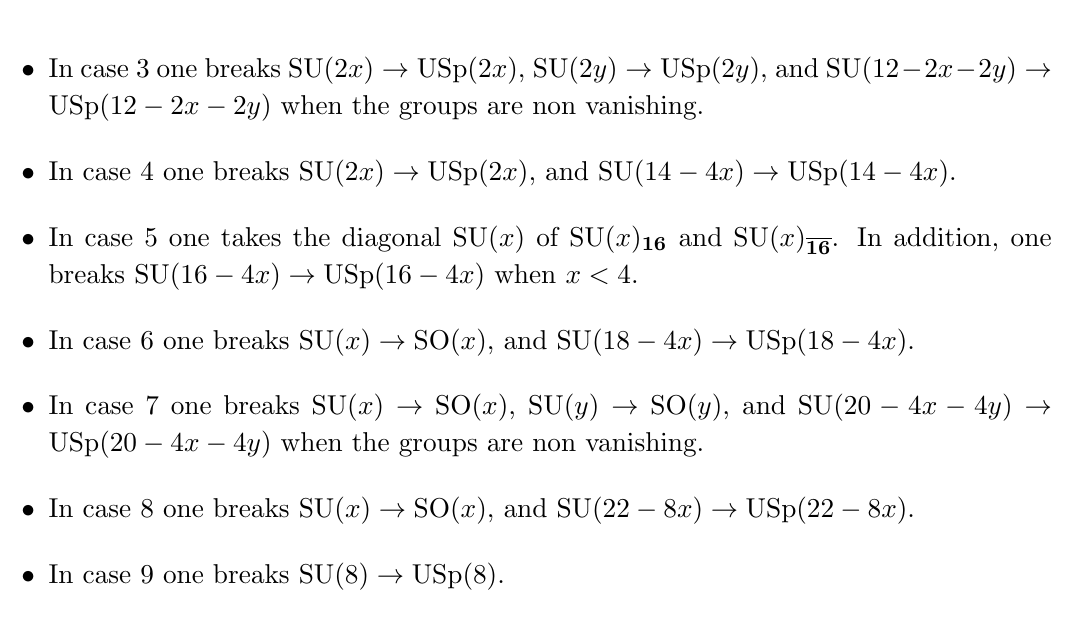
Table 31 . Cases involving an exceptional gauge group with extended supersymmetry. All cases also have an adjoint chiral (cid:12)eld in addition to the matter written in the